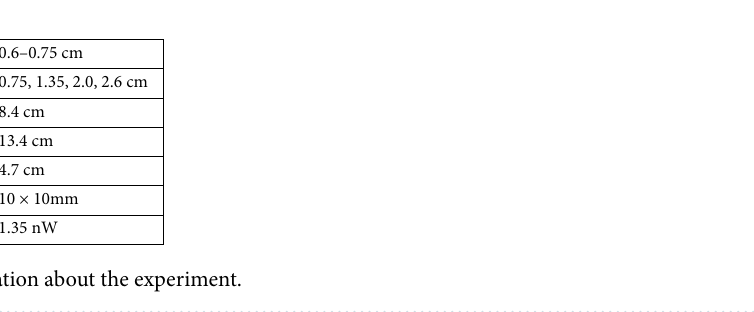
Figure 4. Photo of light propagating through the tissues.